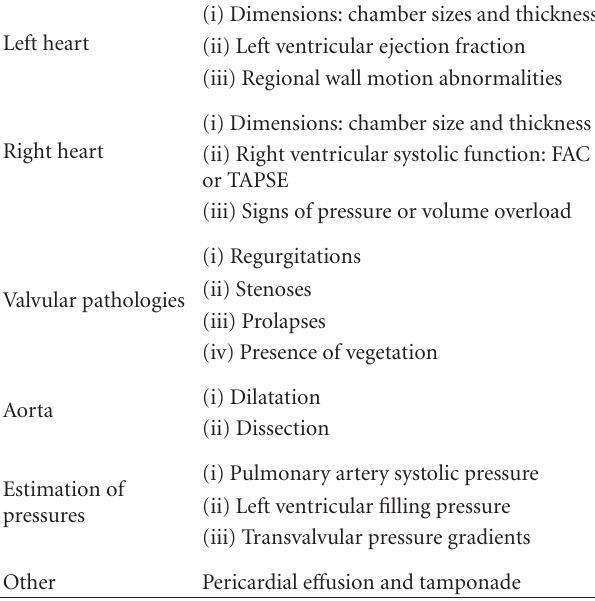
Table 1: Common cardiac information which can be provided by a standard TTE.